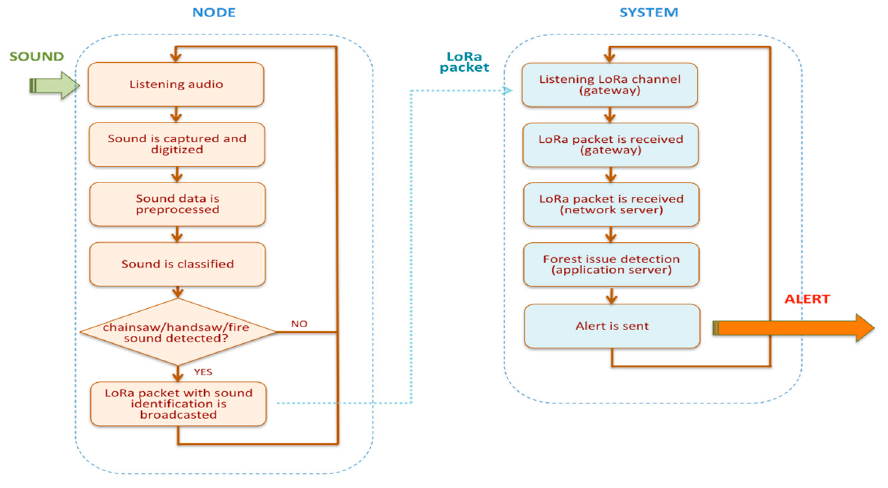
Figure 2. Operational flowchart.